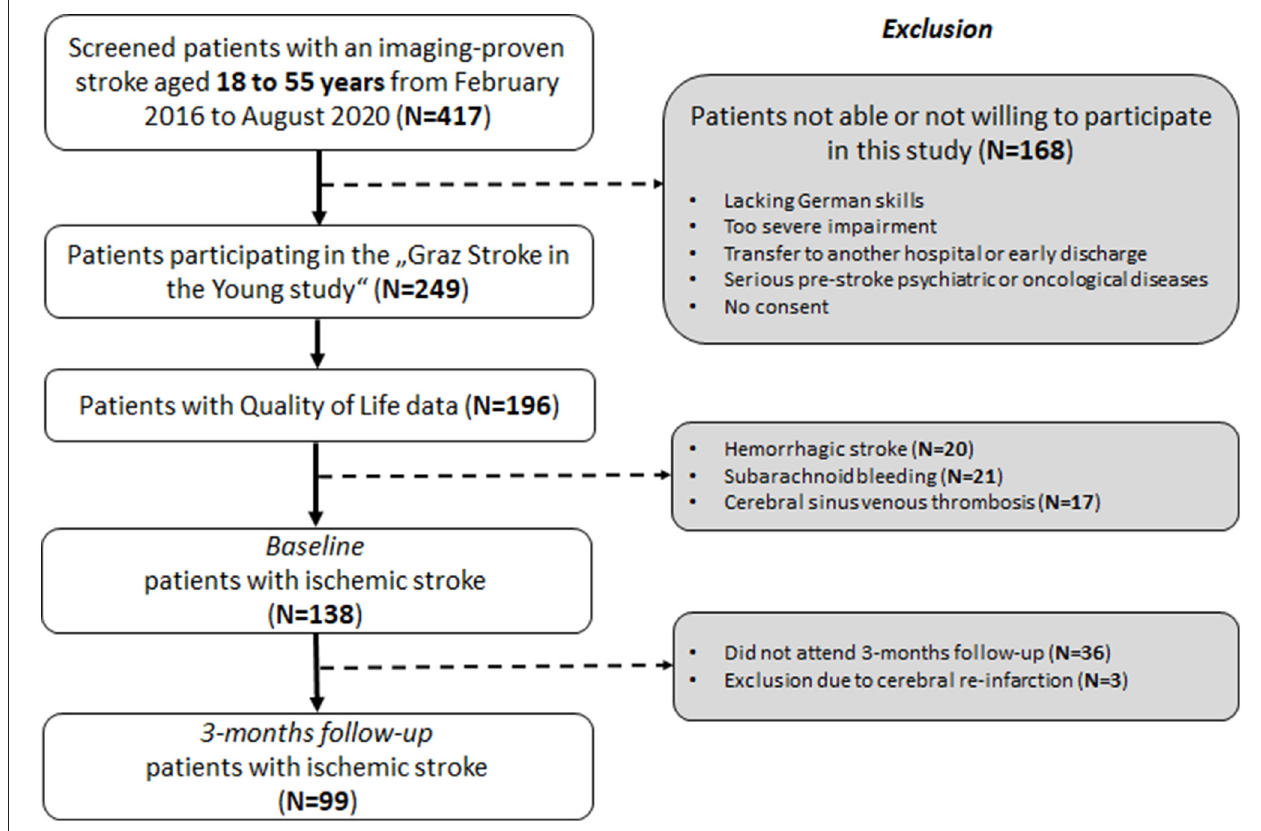
FIGURE 1 | Flowchart of patient selection.